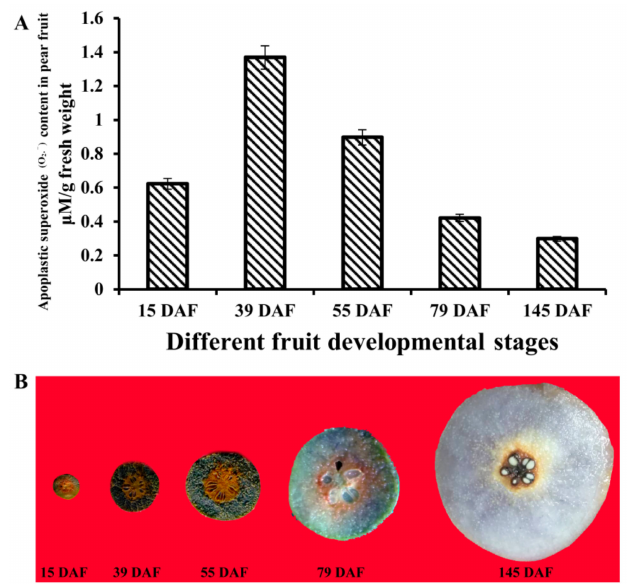
Figure 8. Analysis of apoplastic superoxide content in pear fruit at di ff erent developmental stages. ( A ) The content of O 2 . − in pear fruits at di ff erent developmental stages. ( B ) Specific histochemical staining of apoplastic superoxide in pear